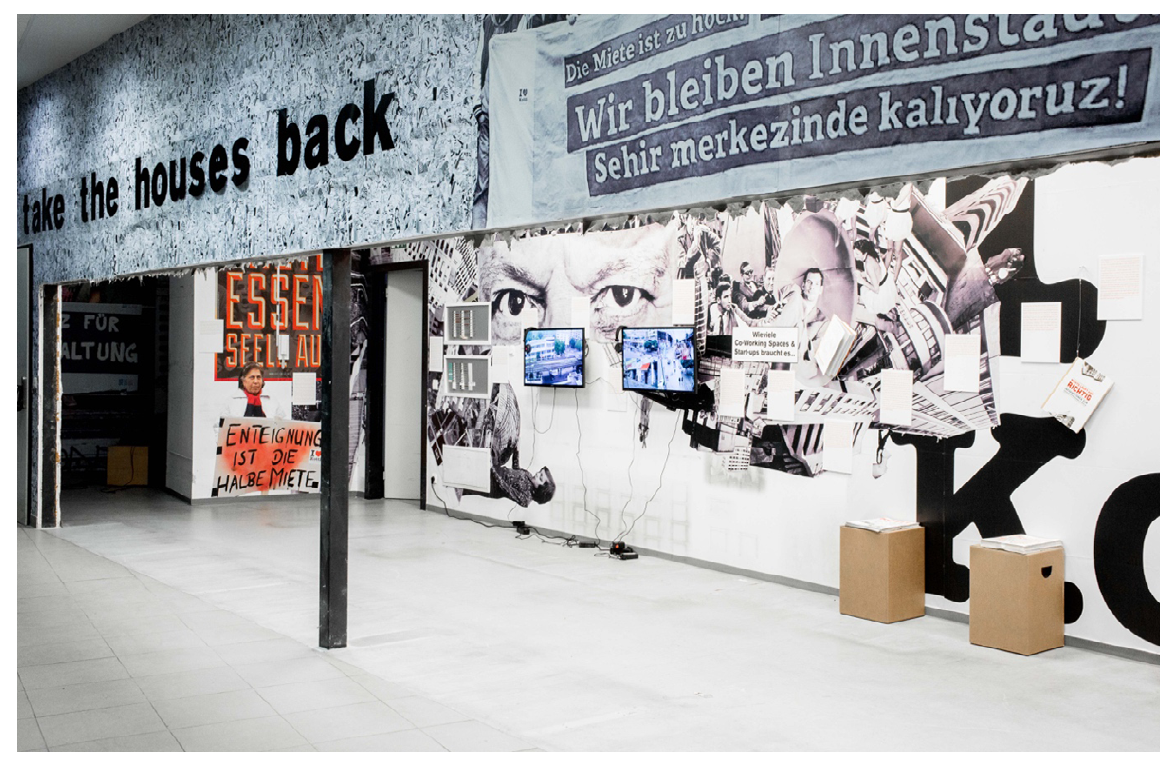
Installation of Kotti & Co / Kotti-Coop / Kotti-Shop / SuperFuture: [Der Kotti ist kein Ponyhof] https://www.hebbel-am-ufer.de/programm/pdetail/kotti-shop-der- kotti-ist-kein-ponyhof/ at Berlin bleibt! Festival 2019, photo Monique